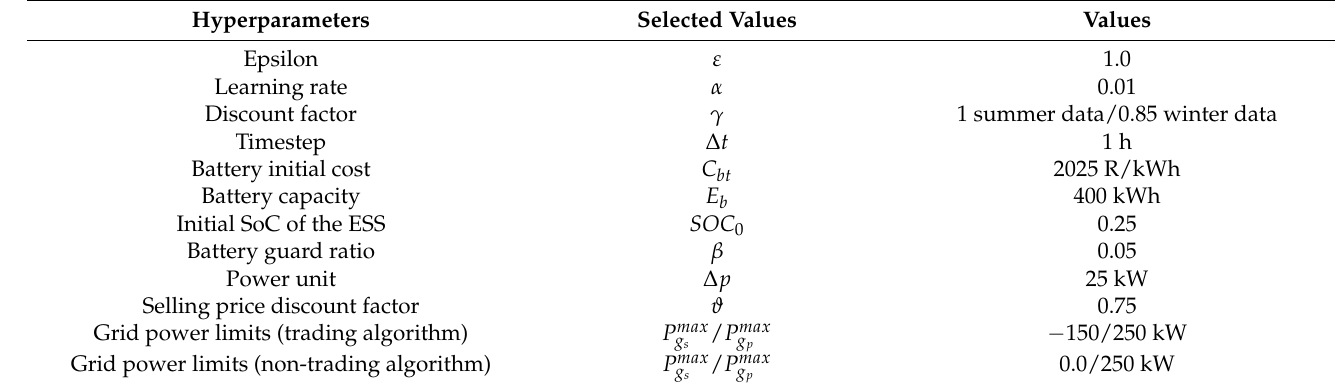
Table 1. Simulation